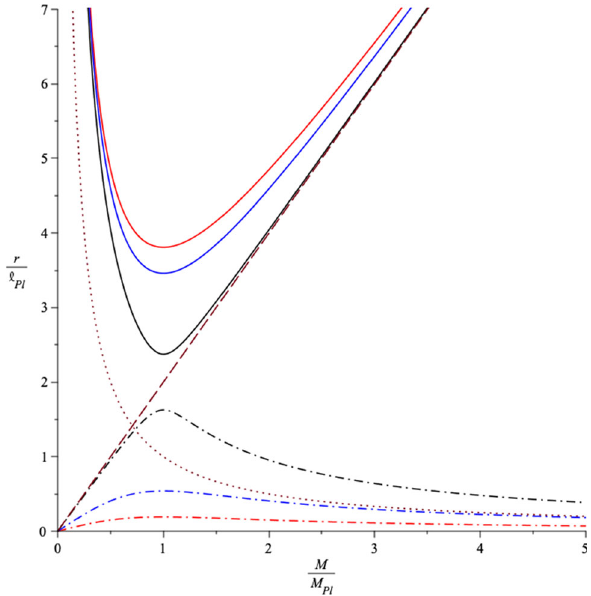
Fig. 5 Outer (top, solid) and inner (bottom, dash-dot) horizons for GUP-RN black holes with β = 2 and n = 10 (red), n = 16 (blue) and n = 23 (black). The dashed/dotted lines show the usual Schwarzschild/Comptonscales.Thereisadiscontinuitywhen n exceeds 23, this being the closest to the extremal solution. The inner horizon is nearly asymptotic to the Compton wavelength at large M for n = 16